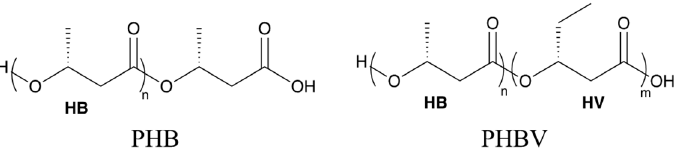
Figure 1. Chemical structures of polyhydroxybutyrate (PHB) and poly(hydroxybutyrate- co -hydroxyvalerate) (PHBV).